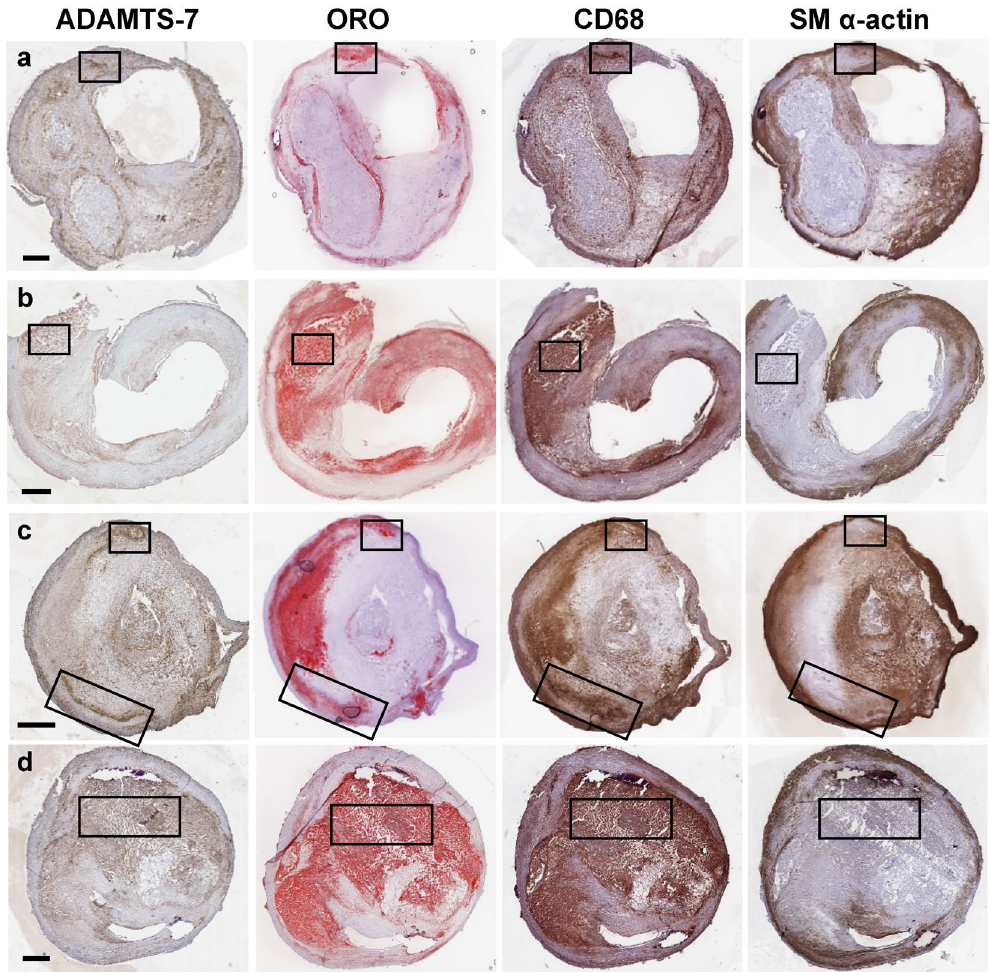
ADAMTS-7, lipids, and CD68-staining are boxed. Scale bar: 1000 μ